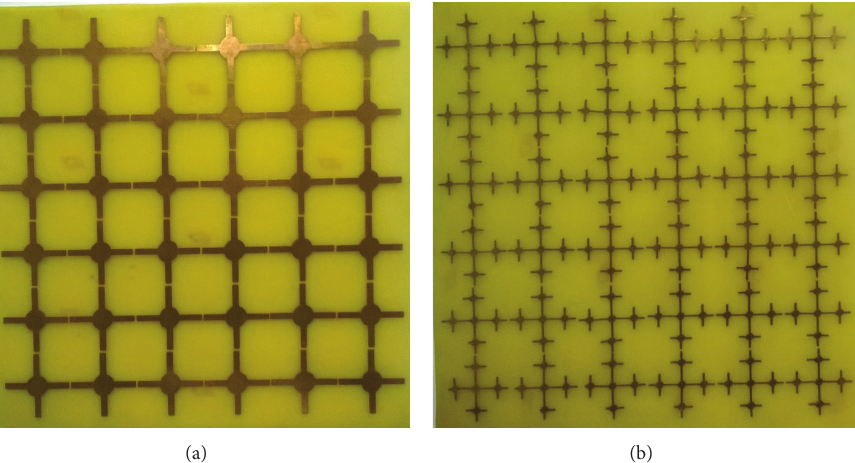
Figure 2: Photographs of FSS prototypes fabricated with cross fractal patch element geometries: (a) generator and (b) first fractal iteration.